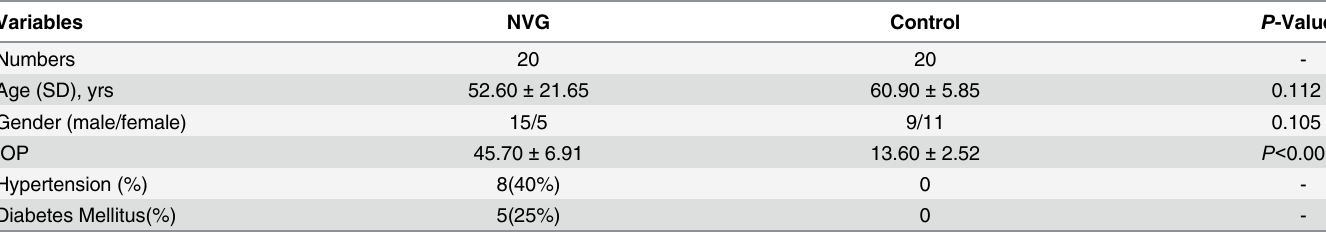
Table 1. Clinical characteristics in study